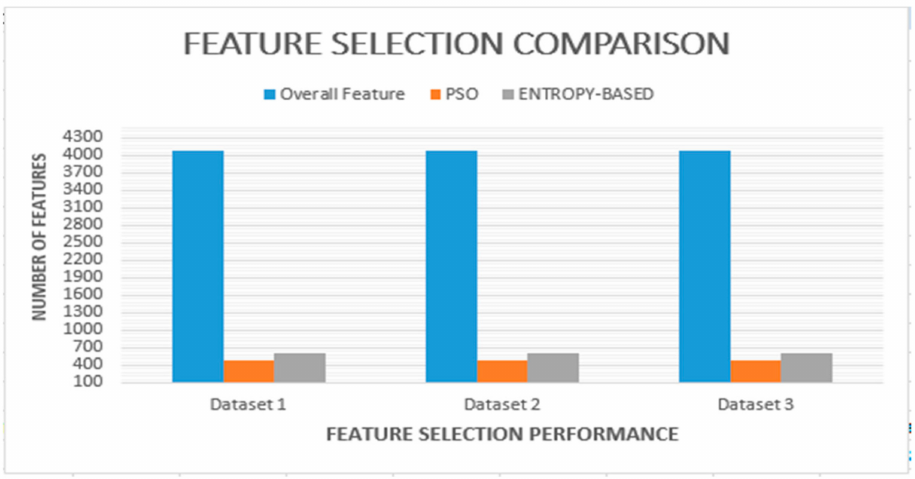
Figure 11. Performance feature selection performance.